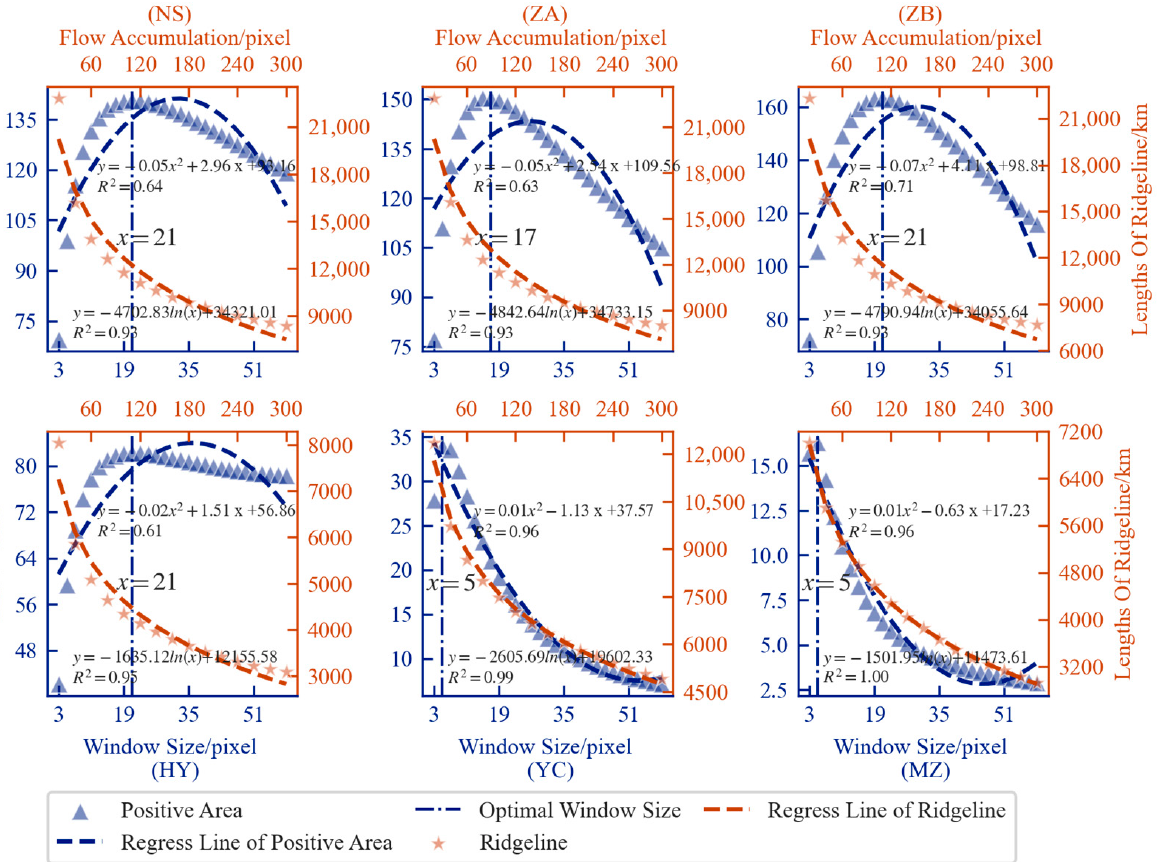
Figure 7. The results of positive terrain extracted with different window sizes of neighborhood anal- ysis in Ningshan County: ( a – f ) the positive terrain distribution of Ningxia County extracted with different window sizes of neighborhood analysis. The positive terrain areas are shown as blue, the upper left corners are the window sizes of these subplots, the analysis window sizes from subplot ( a ) to subplot ( f ) are 3, 11, 21, 31, 41 and 51, respectively. Among them, subplot ( c ) shows positive